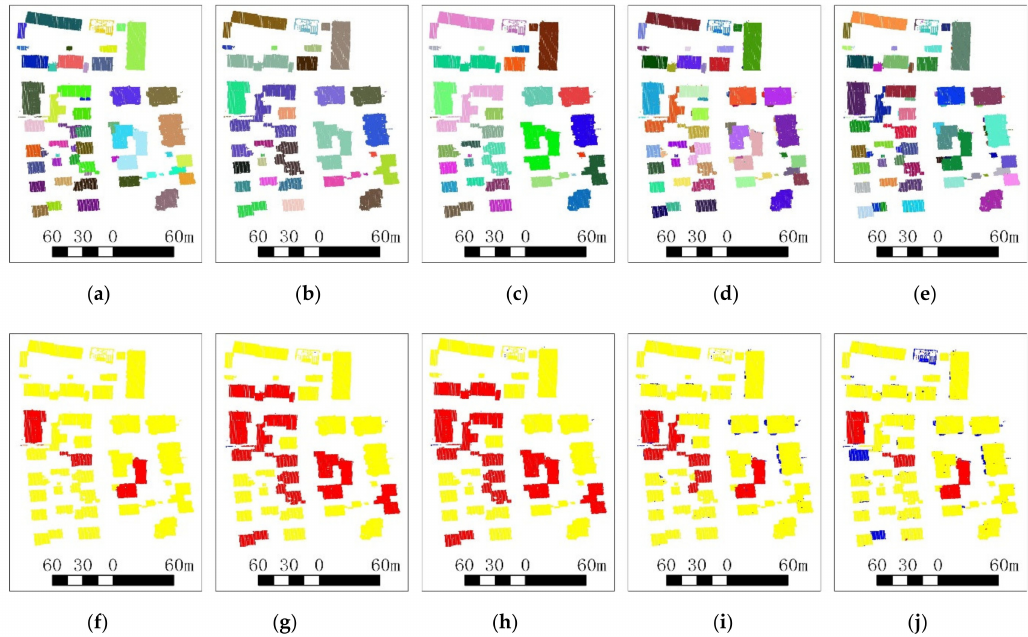
Figure 15. Building instance segmentation result comparison of dataset 3: ( a ) Result of the UBIS method; ( b ) result of the MV method; ( c ) result of the ES2D method; ( d ) result of the ES3D method; ( e ) result of the LCCP method; ( f ) the main differences between the result of the UBIS method and the ground truth; ( g ) the main differences between the result of the MV method and the ground truth; ( h ) the main differences between the result of the ES2D method and the ground truth; ( i ) the main differences between the result of the ES3D method and the ground truth; ( j ) the main differences between the result of the LCCP method and the ground